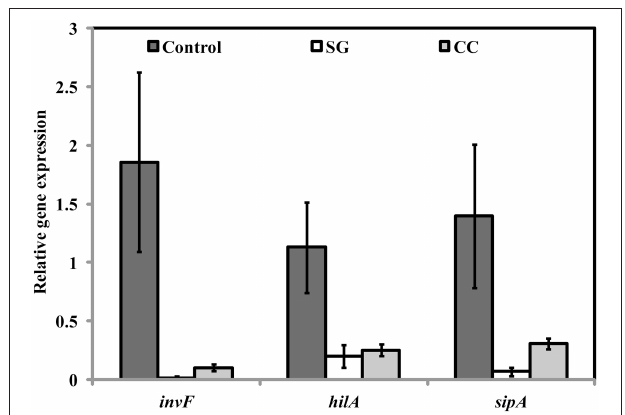
FIGURE 6 | Effect of SWE on the relative expression of virulent genes. SPI-1 encodes genes ( sdiA , hilA , fliD , sipA, and invF ) required for the invasion of S. Enteritidis into the host epithelium (Type 3 secretion system). Values with different superscript letters are significantly different (Tukey multiple mean comparison, p < 0.05). Values represent Mean ± Standard deviation from three independent experiments; each experiment had three biological